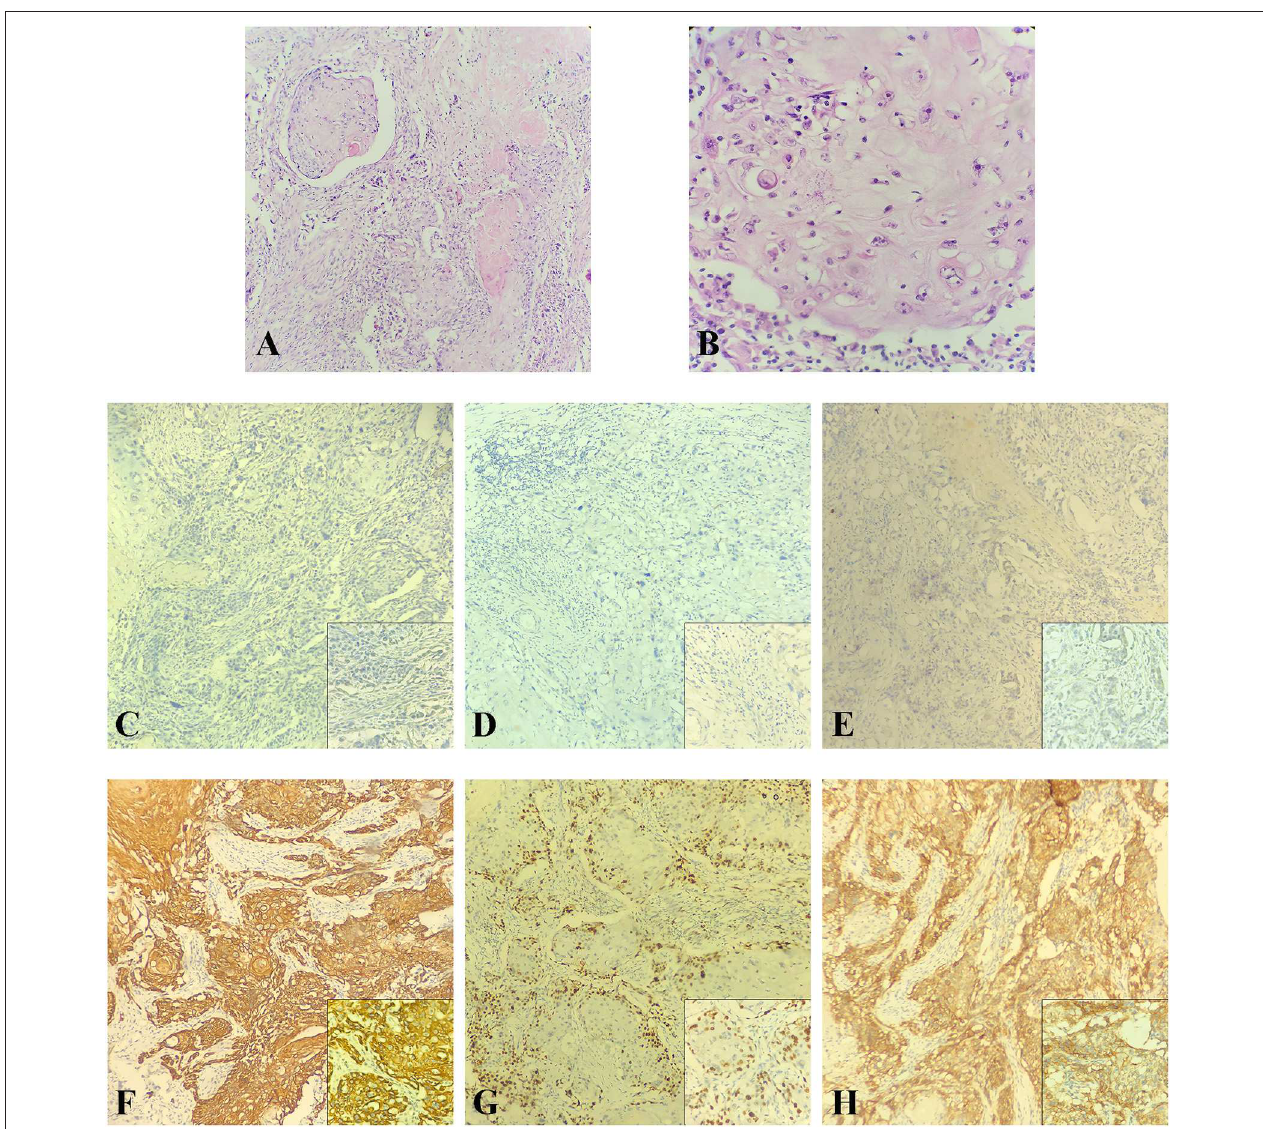
FIGURE 4 | The postoperative pathological examination with HE staining and IHC staining of the recurrent tumor in 2018. (A,B) Histological findings with HE staining showed that the recurrent tumor was a metaplastic squamous cell carcinoma with prominent keratinization that exhibited an infiltrative growth pattern. (A) Original magnification (10 × ). (B) High magnification (40 × ). (C–H) IHC staining was used to detect the expressions of ER, PR, HER-2, CK5/6, Ki-67, and EGFR at original magnification (10 × ). (C) ER negative. (D) PR negative. (E) HER-2 negative. (F) CK5/6 positive. (G) Ki-67 positive (70%). (H) EGFR